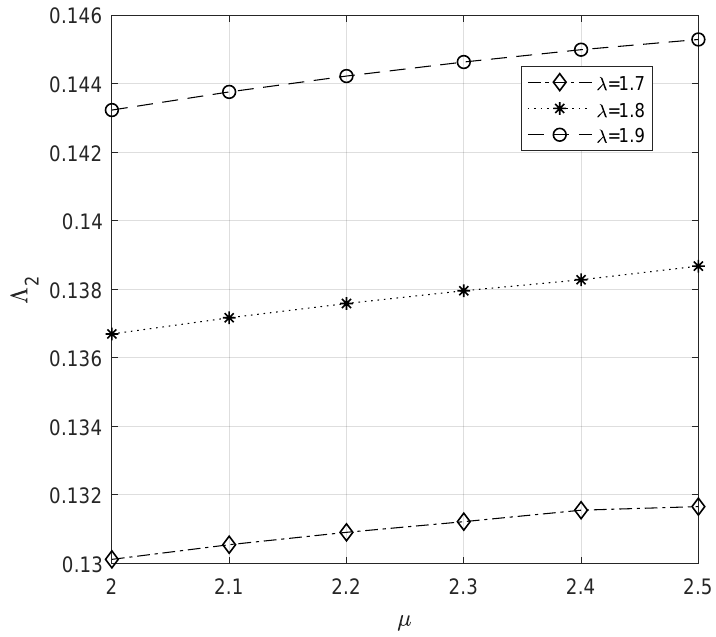
Figure 15. The impact of mean reorder rate when λ vs. µ .